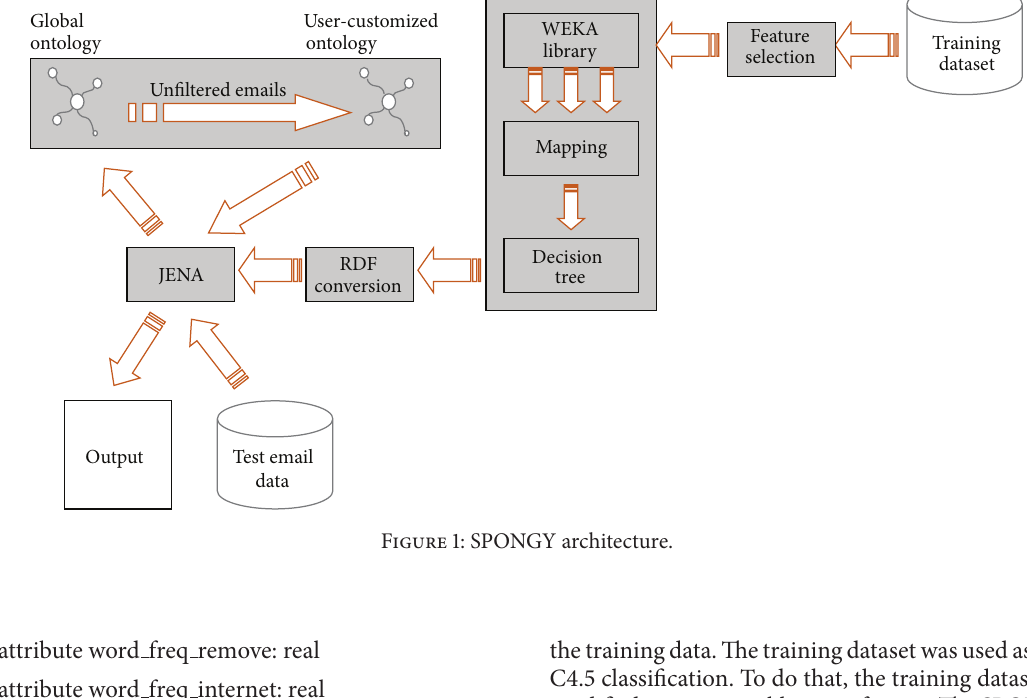
Figure 1: SPONGY